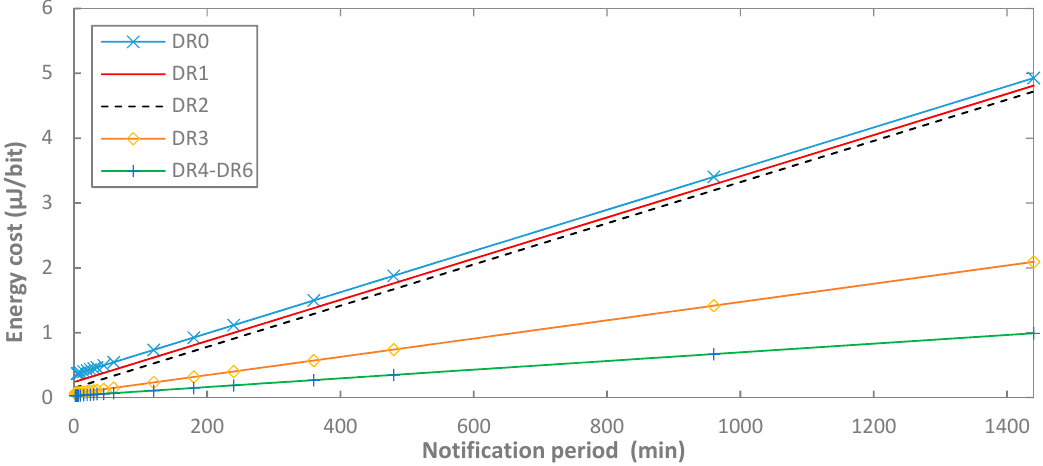
Figure 18. Energy cost of data delivery as a function of T Notif , for different DR settings, and for BER = 0 and p coll = 0. Results for DR4, DR5 and DR6 overlap in the figure.